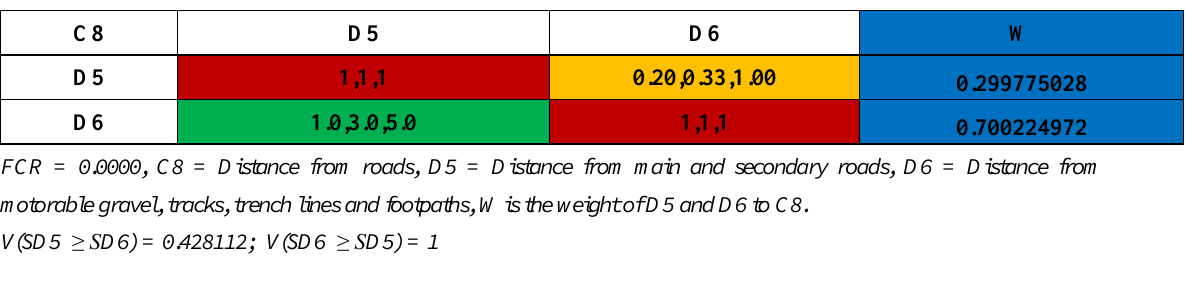
Table 11. The pairwise comparison matrix, C